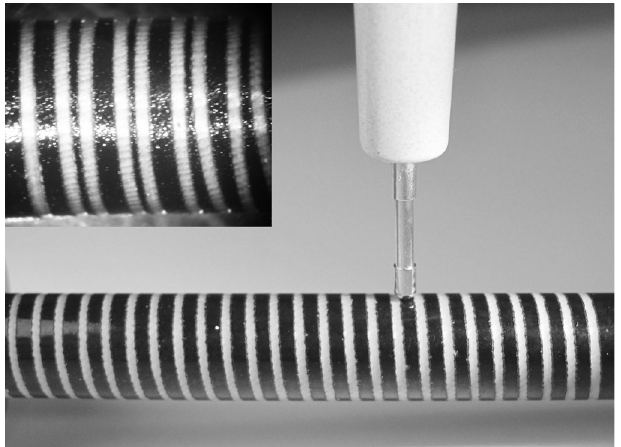
FIG. 8. Experimental setup for measuring the voltage distribu- tion across a gigaohm resistor to locate a “ microbreak. ” A 982 M Ω Welwyn resistor and an INFINITRON Model 800P probe are shown. The inset shows the Welwyn resistor with a nonuniform distribution of the width of the helix conductive layer